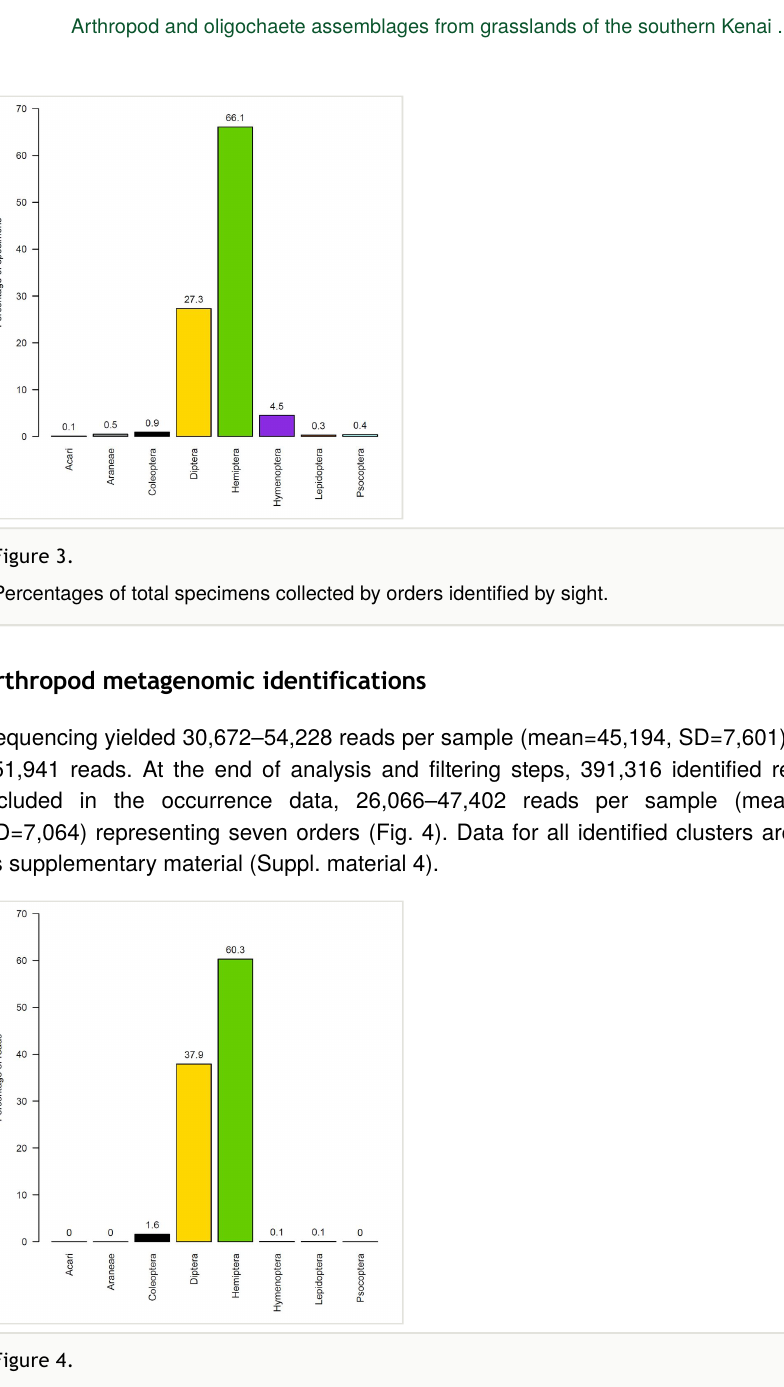
Percentages of the total numbers of reads by